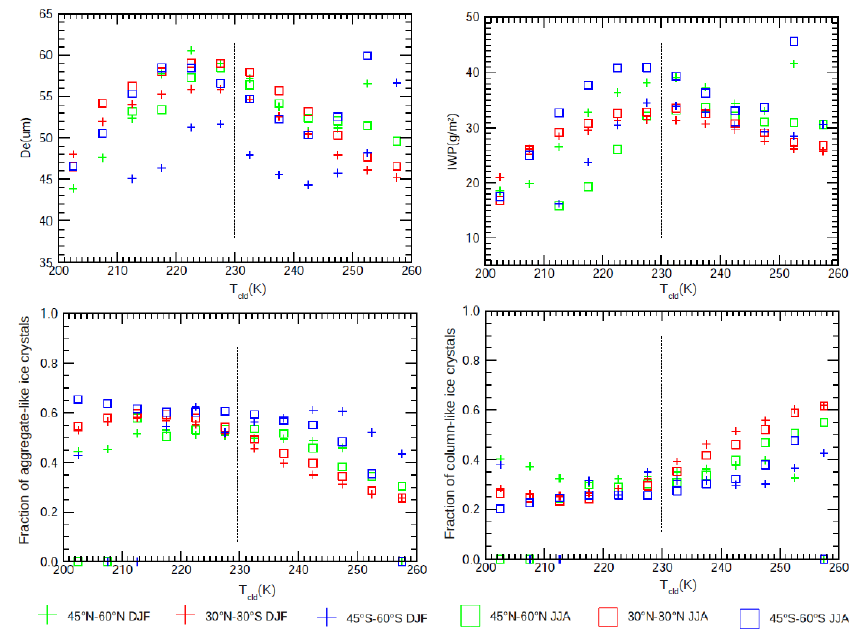
Fig. 5. Bulk microphysical properties as function of cloud temperature, averaged over the period 2003–2009. Crosses and squares represent averages over boreal winter and over boreal summer, respectively. Green symbols are for NH midlatitudes, red for the tropics and blue for SH midlatitudes. The vertical line at T cld =230 K represents the temperature threshold below which the microphysical property retieval is applied.